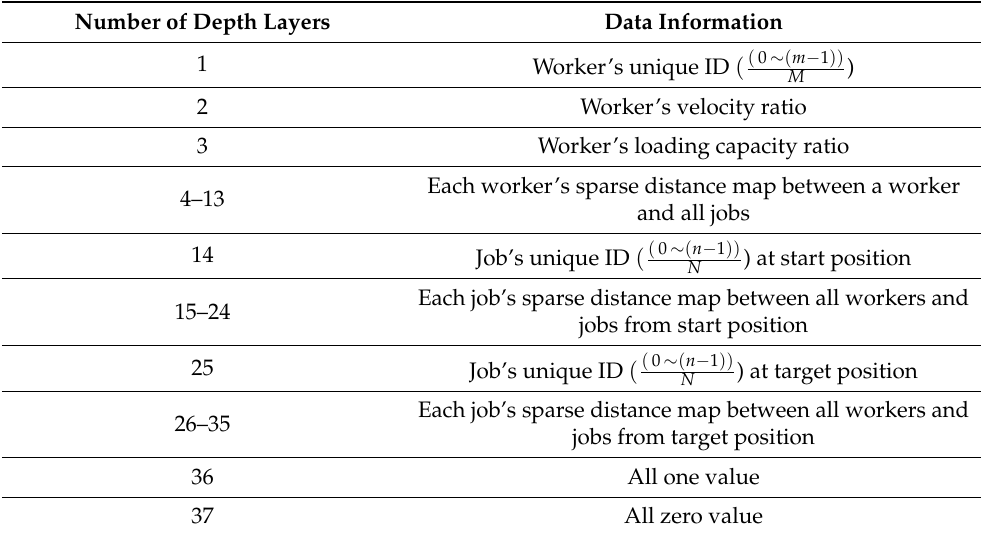
Table 1. Data Information for Each Layer in the Depth Direction of the Dataset. Number of Depth